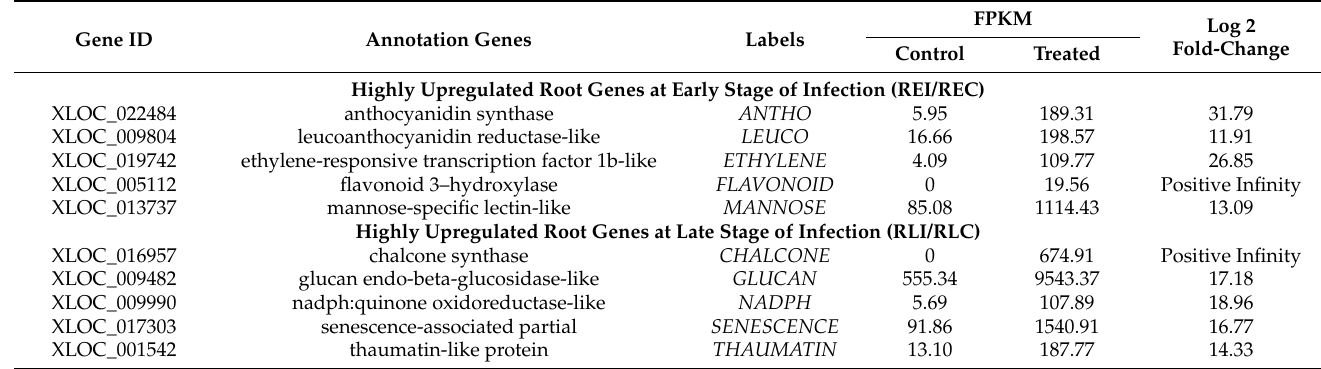
Table 3. List of the selected differentially expressed genes in oil palm root samples at different stages of G. boninense infection.